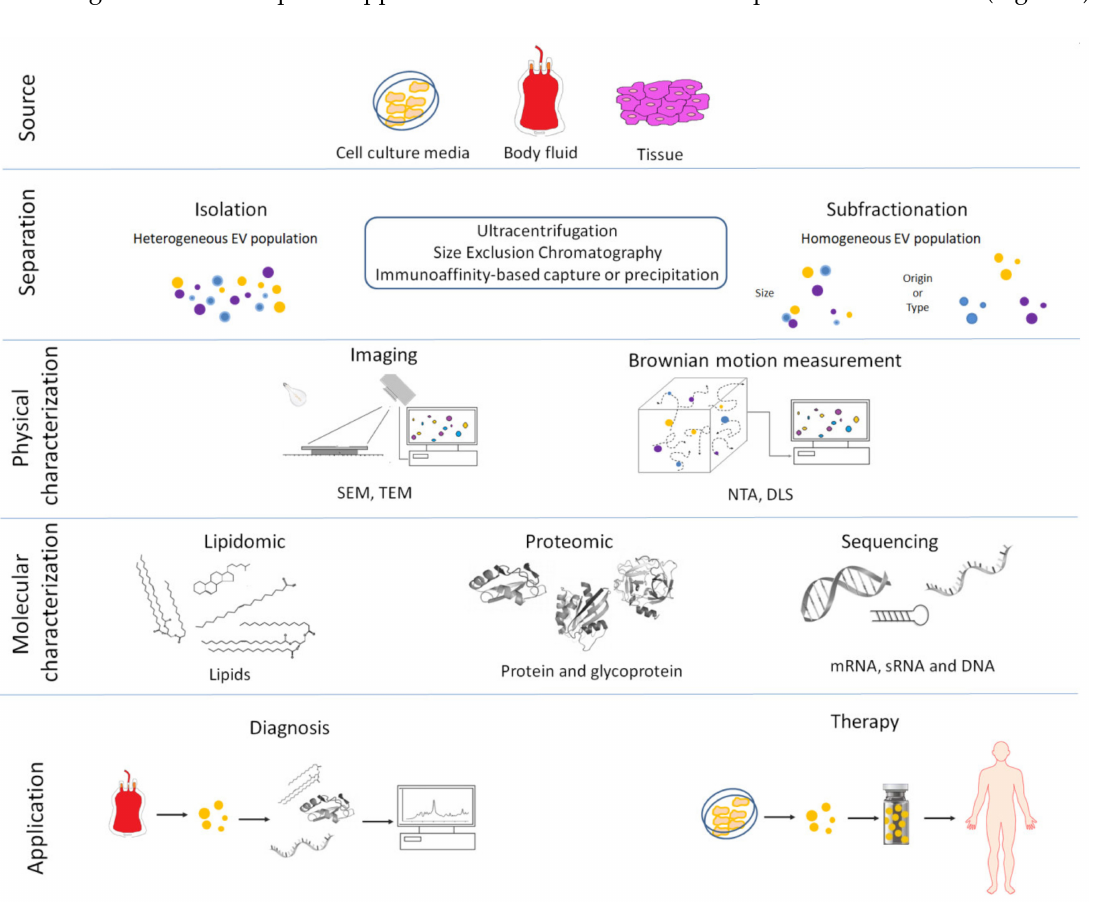
Figure 1. Overview of the main procedures used for the isolation, characterization and clinical use of extracellular vesicles (EVs). (1) Extracellular vesicles are released by cells into the culture media or from tissue into the extracellular environment. (2) Extracellular vesicles are separated or further purified to obtain a more homogeneous EV population using a variety of methods. (3) Isolated EVs are physically characterized by: Scanning Electron Microscopes (SEM), Transmission Electron Microscopes (TEM), Nanoparticle Tracking Analysis (NTA) and Dynamic Light Scattering (DLS). (4) Extracellular vesicles are molecularly characterized using several techniques. (5) Biomarkers can be obtained by molecular profiling of isolated EVs from in vitro cell cultures or body fluids in pathologic condition and used as diagnostic tools for several human and veterinary diseases. Isolated EVs can also be used as treatments in human and veterinary